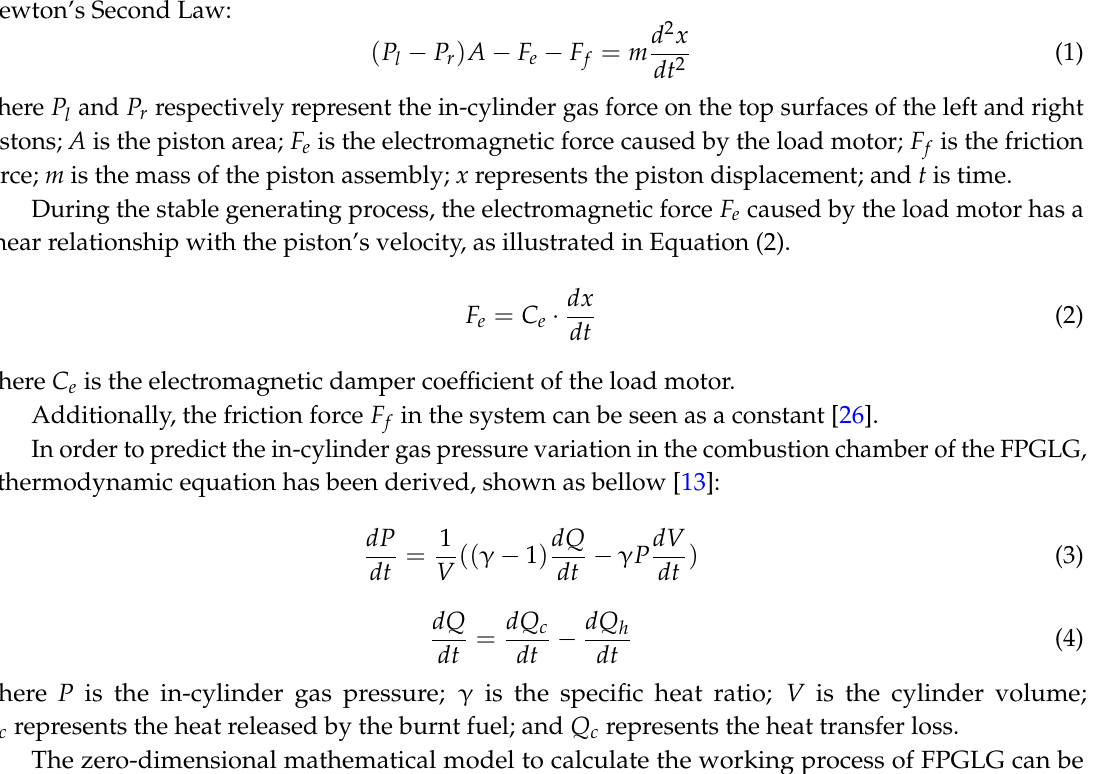
Figure 3. Forces acting on the piston assembly of the FPGLG.